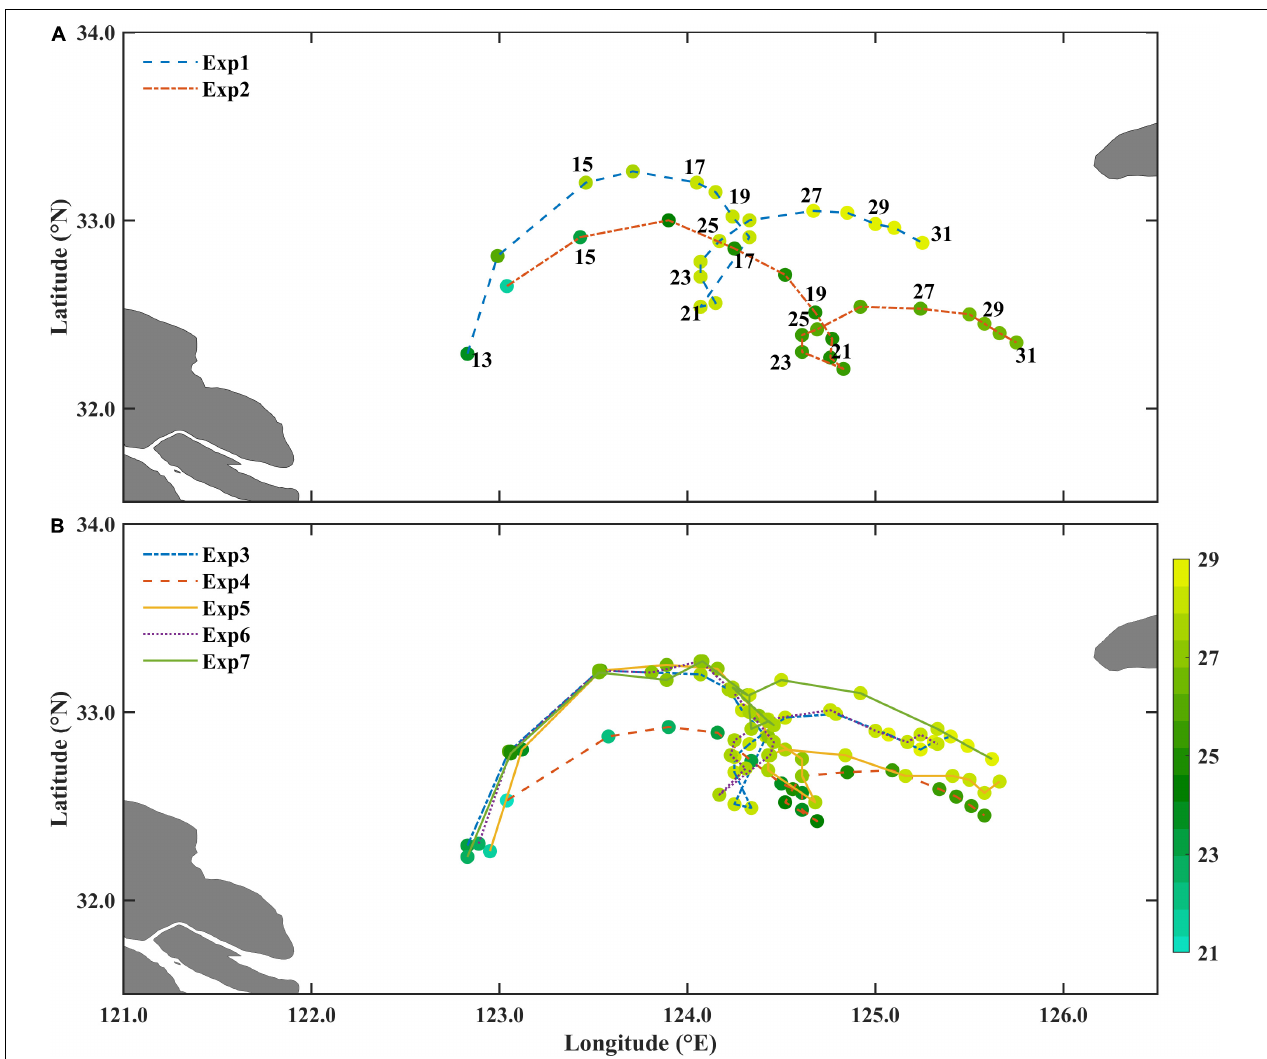
FIGURE 11 | The trajectory of the LSW center since the detachment in (A) Exp1 (CR) and Exp2 (NoWave), and (B) Exp3 (NoCWCBS), Exp4 (NoFormDrag), Exp5 (NoWDinTKE), Exp6 (NoWRS), and Exp7 (NoCARWE), respectively. Color circles indicate the core salinity of the LSW and the numbers indicate the day of July.